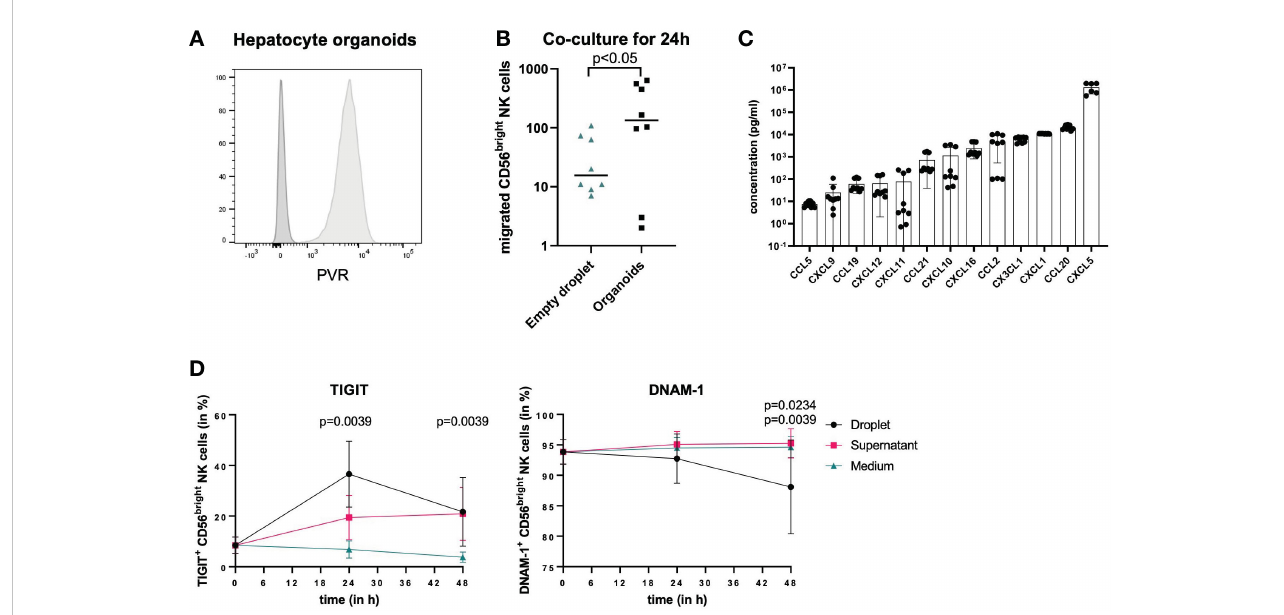
FIGURE 5 Co-culture of NK cells and hepatocyte organoids. (A) Representative histograms comparing PVR staining (light grey) and unstained control (dark grey) of hepatocyte organoids demonstrating PVR expression on hepatocytes. (B) NK cells isolated from buffy coats were co-cultured with empty BME2 droplets or hepatocyte organoids in BME2 droplets for up to 48h. Graph displaying total cell count of CD56 bright NK cells that migrated into BME2 droplets at 24 hours of co-culture with empty droplets (blue triangles) or hepatocyte organoids (black dots). Wilcoxon matched-pairs sign rank test was used for statistical analysis. Black line indicates median. (n=3, triplicates) (C) Chemokine concentrations in hepatocyte organoid culture supernatants are shown in ascending order on a logarithmic scale. Bars represent mean values of three experiments in triplicates for each chemokine and error bars show standard deviations (n=3, triplicates). (D) Migrated CD56 bright NK cells (black dots) were phenotypically compared to non-migrated cells (pink squares) and to separately cultured NK cells that did not have any contact to hepatocyte organoids (blue rectangles). Percentage surface expression of TIGIT and DNAM-1 is shown in CD56 bright NK cells after 24 hours and 48 hours. For TIGIT, statistical differences represent comparison of migrated NK cells as well as non-migrated NK cells vs. NK cells in medium and for DNAM-1 statistical differences represent migrated NK cells vs. NK cells in medium (top value) or non-migrated cells (lower value). Wilcoxon matched-pairs sign rank test was used for statistical analysis. Each dot represents the median of nine experiments; error bars represent the data